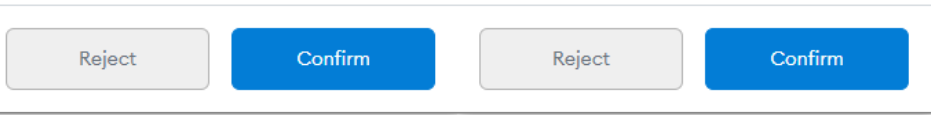
Figure 7. MetaMask wallet for seller and buyer.